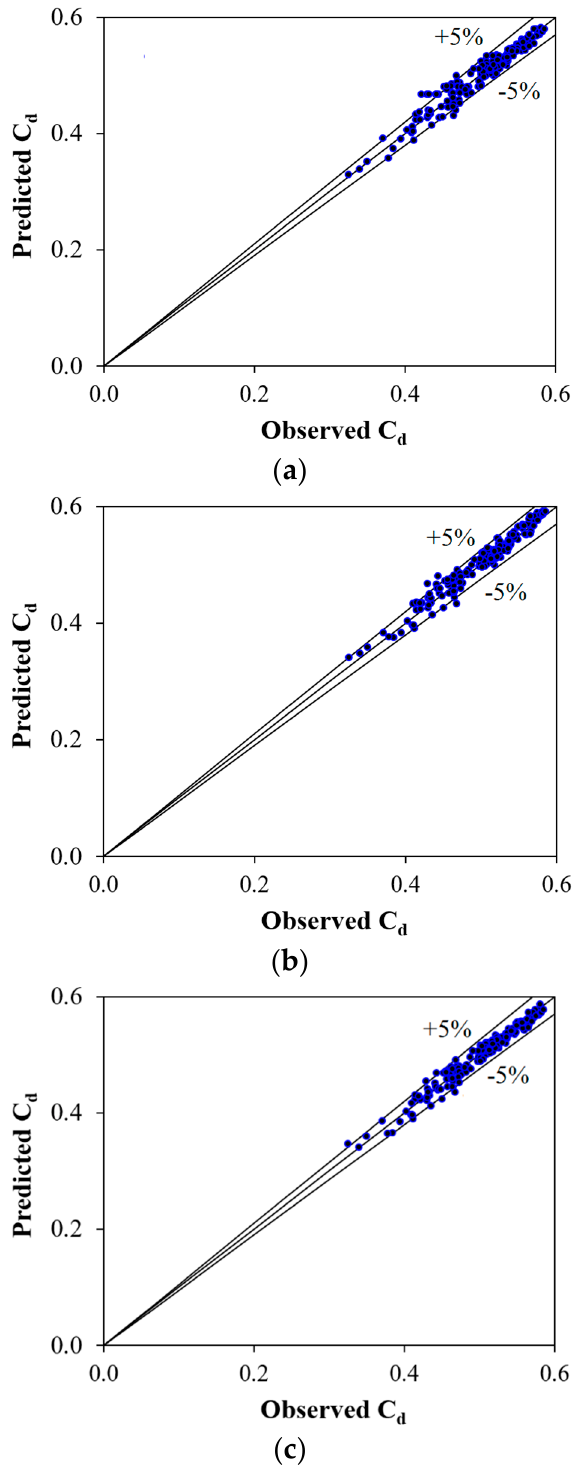
Figure 6. Observed and predicted C d for all models for the best input combination in the test period